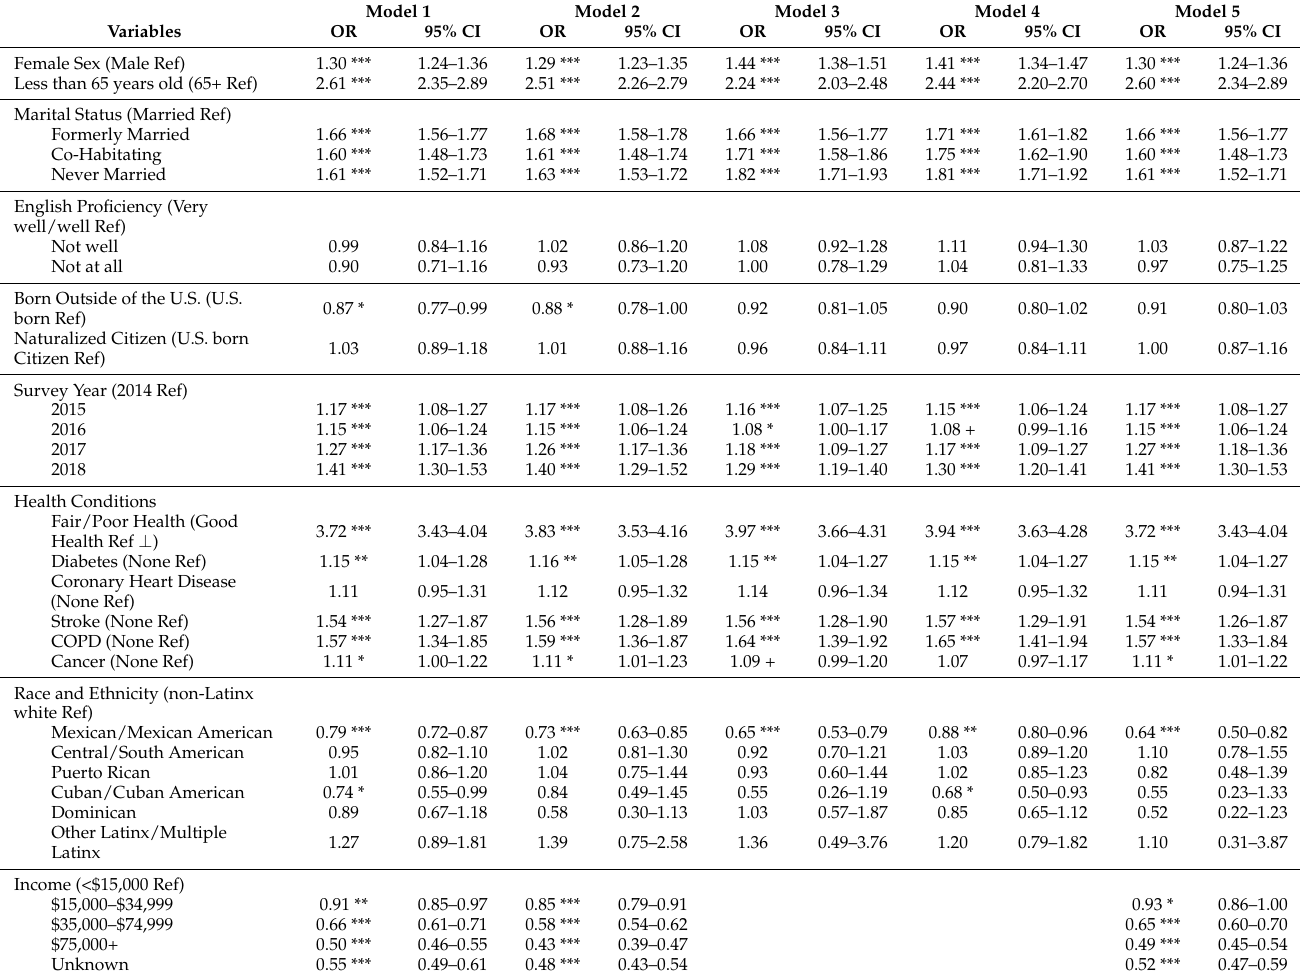
Table 4. Weighted Multivariate Ordinal Logistic Regression of Psychological Distress on Income, Education, Employment, and